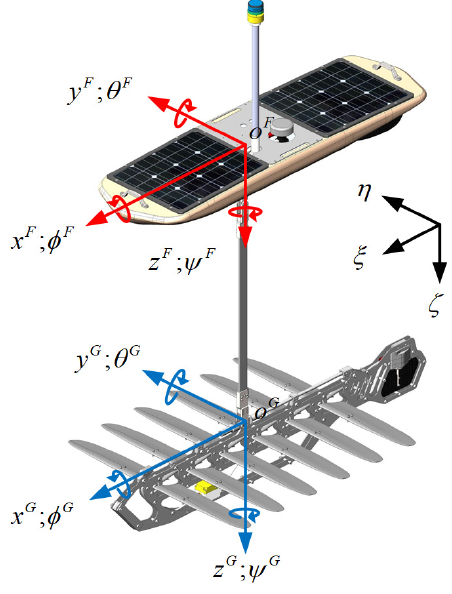
Figure 2. The coordinate frames of the “Black Pearl” wave glider.